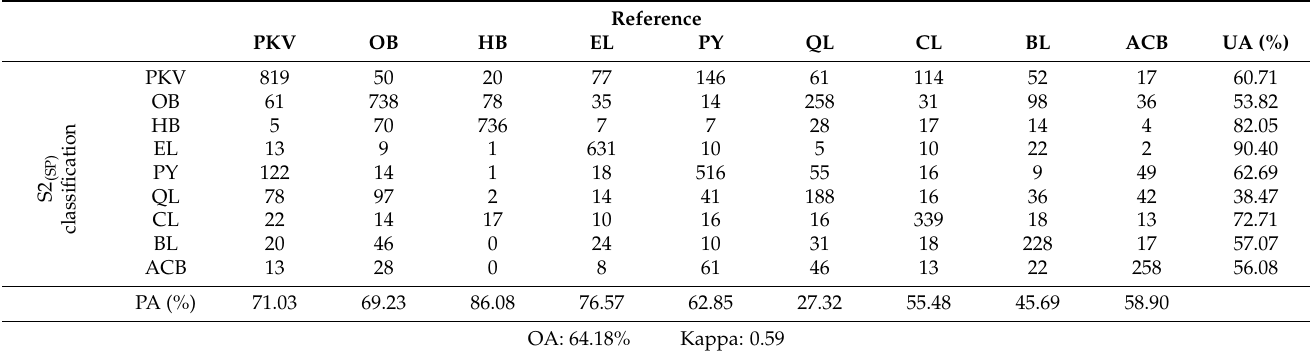
Table A1. Confusion matrix derived using only Sentinel-2 spectral features.